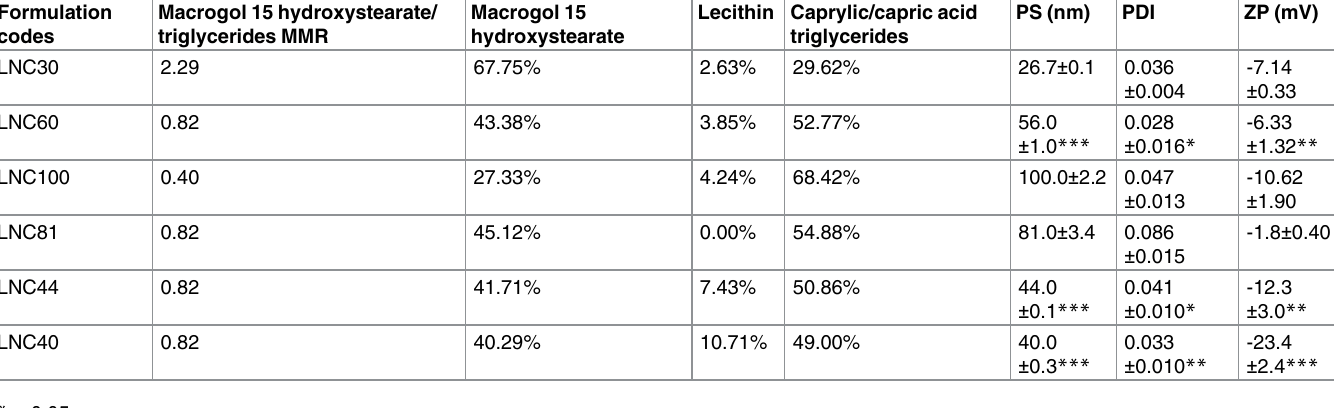
Table 1. Composition and properties of the LNCs. MMR: mass mixing ratio, PS: particle size (mean ± S.D., n = 3), PDI: polydispersity index (mean ± S.D., n = 3), ZP: zeta potential (mean ± S.D., n = 3). Formulation